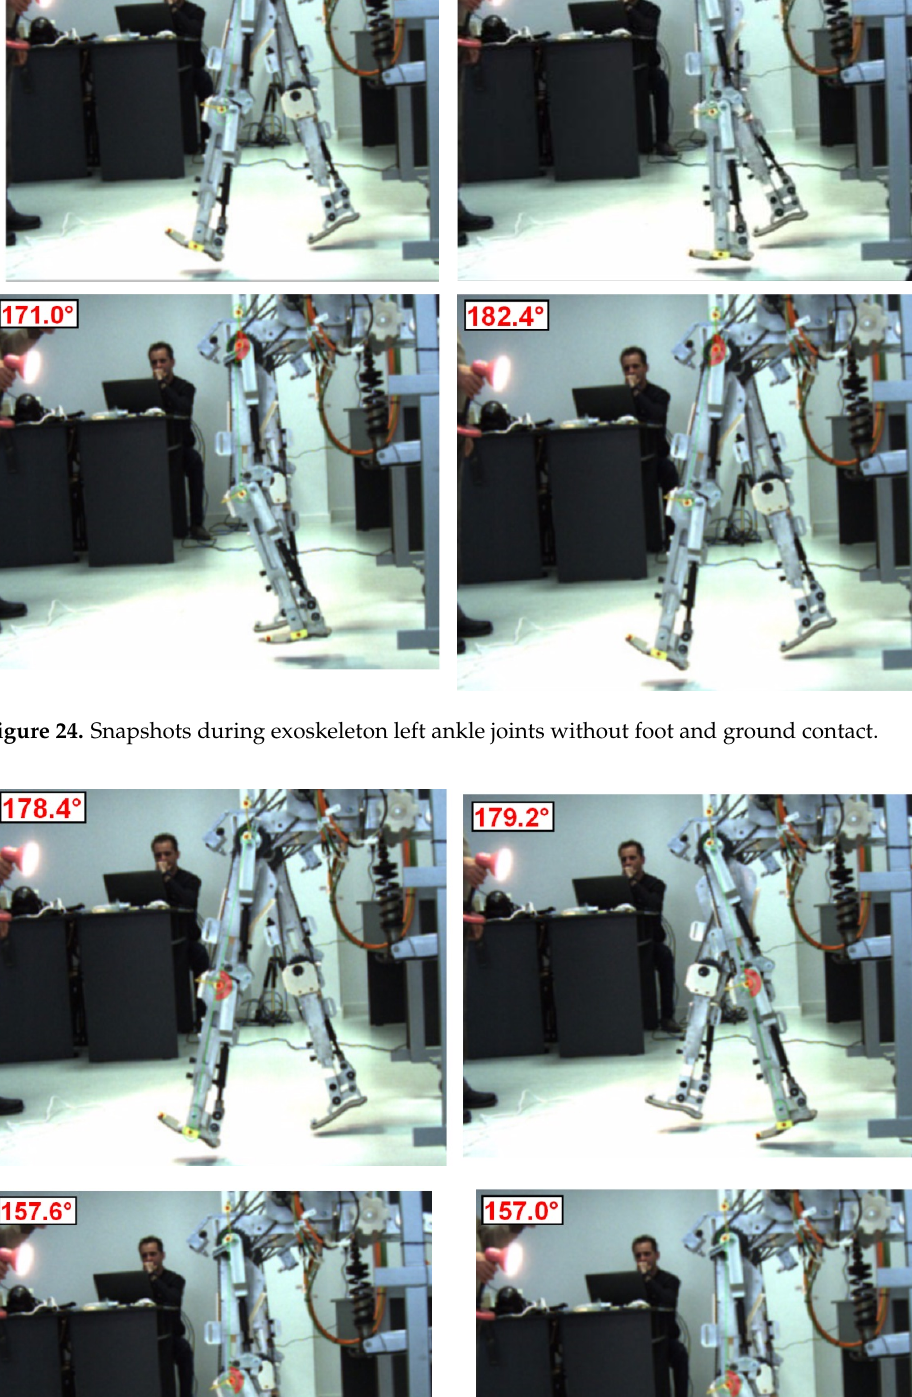
Figure 26. Snapshots during exoskeleton left ankle joint without foot and ground contact. These tests were performed without foot and ground contact to observe the exoskel- eton behavior during walking exercises. This experimental evaluation process was not used by any human volunteers to test this and other experimental tests will be presented in future research. After processing the video sequences, the desired results were obtained for both ex- oskeleton lower limbs. These are shown in Figures 27–29.